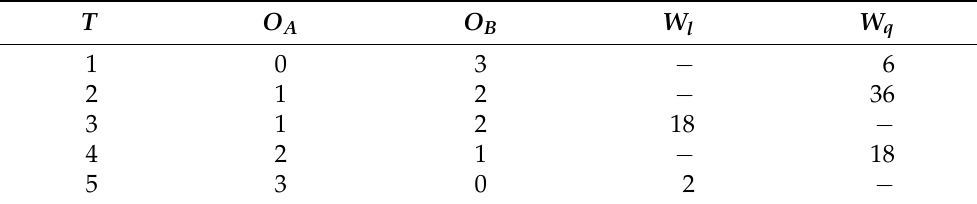
Table 2. Classification of W ( 1,2 ) ’s living in W ( 3,2 ) . Column one ( T ) shows the type, columns two and three ( O A and O B ) indicate the number of observables of corresponding types and columns four ( W l ) and five ( W q ) yield, respectively, the number of ‘linear’ and ‘quadratic’ W ( 1,2 ) ’s of a given